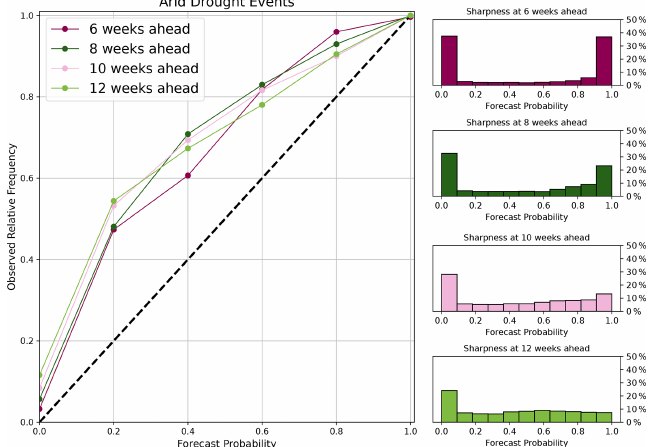
Figure 9. Reliability diagram showing forecast probability and the corresponding observed frequencies for 6-, 8-, 10-, and 12-week lead time together with their corresponding sharpness plots for drought events (VCI3M < 35) in the arid and semi-arid counties.